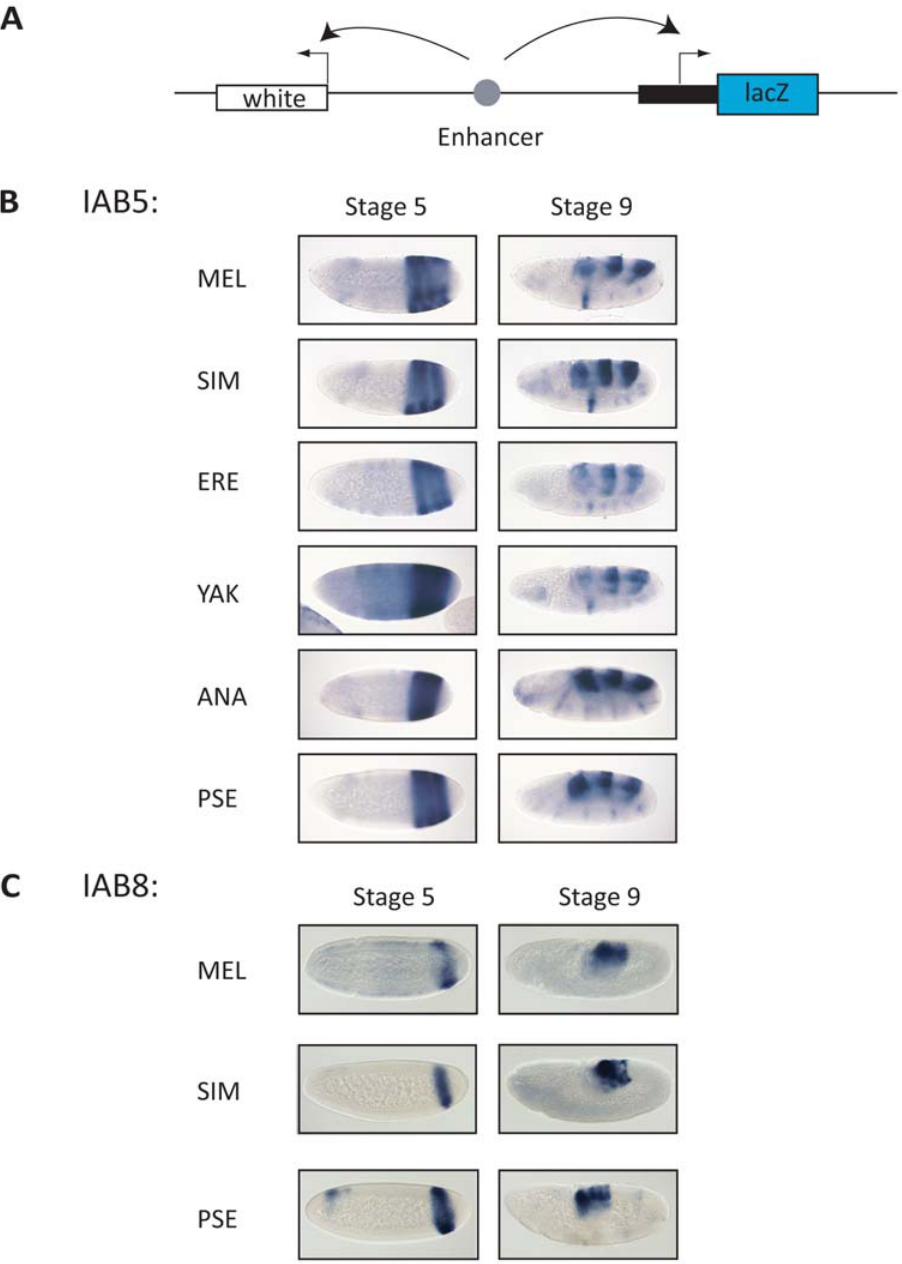
Figure 3. Functional conservation of IAB5 and IAB8 orthologs despite a lack of sequence conservation. (A) P element construct for functional assays. A heterologous IAB5 or IAB8 region (gray circle) is inserted between the white and eve - lacZ reporter genes on the P element reporter construct to test for conserved functional enhancer activity in transgenic D. melanogaster embryos. (B) Transgenic embryos carrying IAB5 orthologs show an IAB5-like lacZ expression pattern. The D. melanogaster IAB5 CRM (MEL) and orthologs of IAB5, identified by sequence alignment in D. simulans (SIM), D. erecta (ERE), D. yakuba (YAK), D. ananassae (ANA), and D. pseudoobscura (PSE) drive expression of the reporter gene lacZ in the characteristic IAB5 pattern in the presumptive fifth, seventh and ninth abdominal segments of stage 5 and stage 9 D. melanogaster embryos. The pattern of white expression in embryos carrying these transgenes is identical (data not shown). (C) Transgenic embryos carrying IAB8 orthologs show an IAB8-like lacZ expression pattern. The D. melanogaster IAB8 CRM and orthologs of IAB8, identified by sequence alignment in D. simulans (SIM) and D. pseudoobscura (PSE), drive expression of the reporter genes lacZ in the characteristic IAB8 pattern in the presumptive eighth abdominal segment of stage 5 and stage 9 D. melanogaster embryos. The pattern of white expression in embryos carrying these transgenes is identical (data not